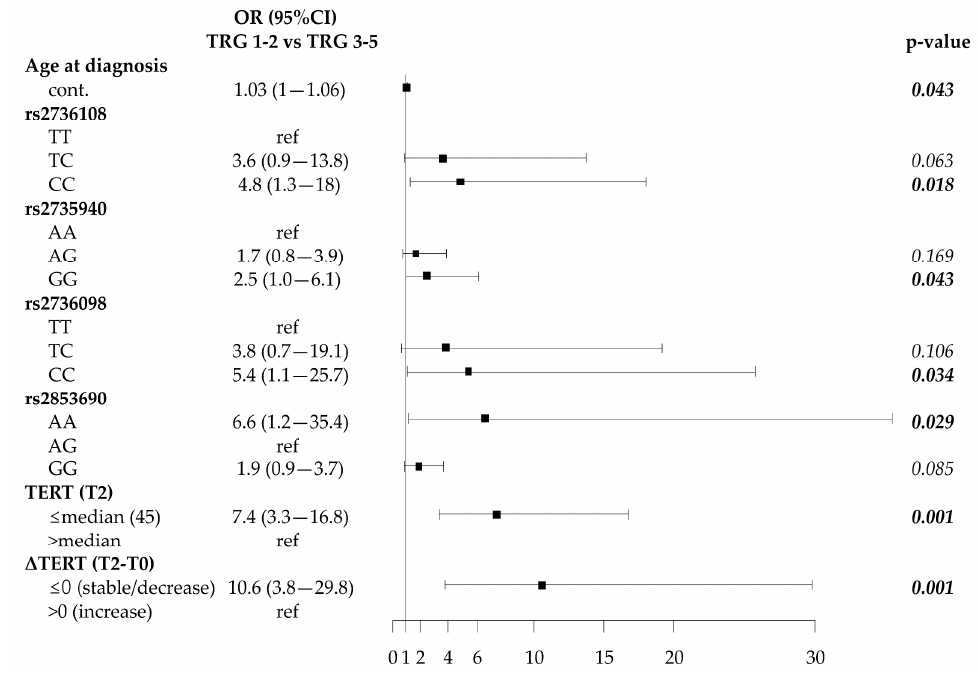
Figure 4. Forest plot showing odds ratios (OR) according to tumor regression grading (TRG) probability using univariate logistic regression analysis. Cont.: continuous variable.